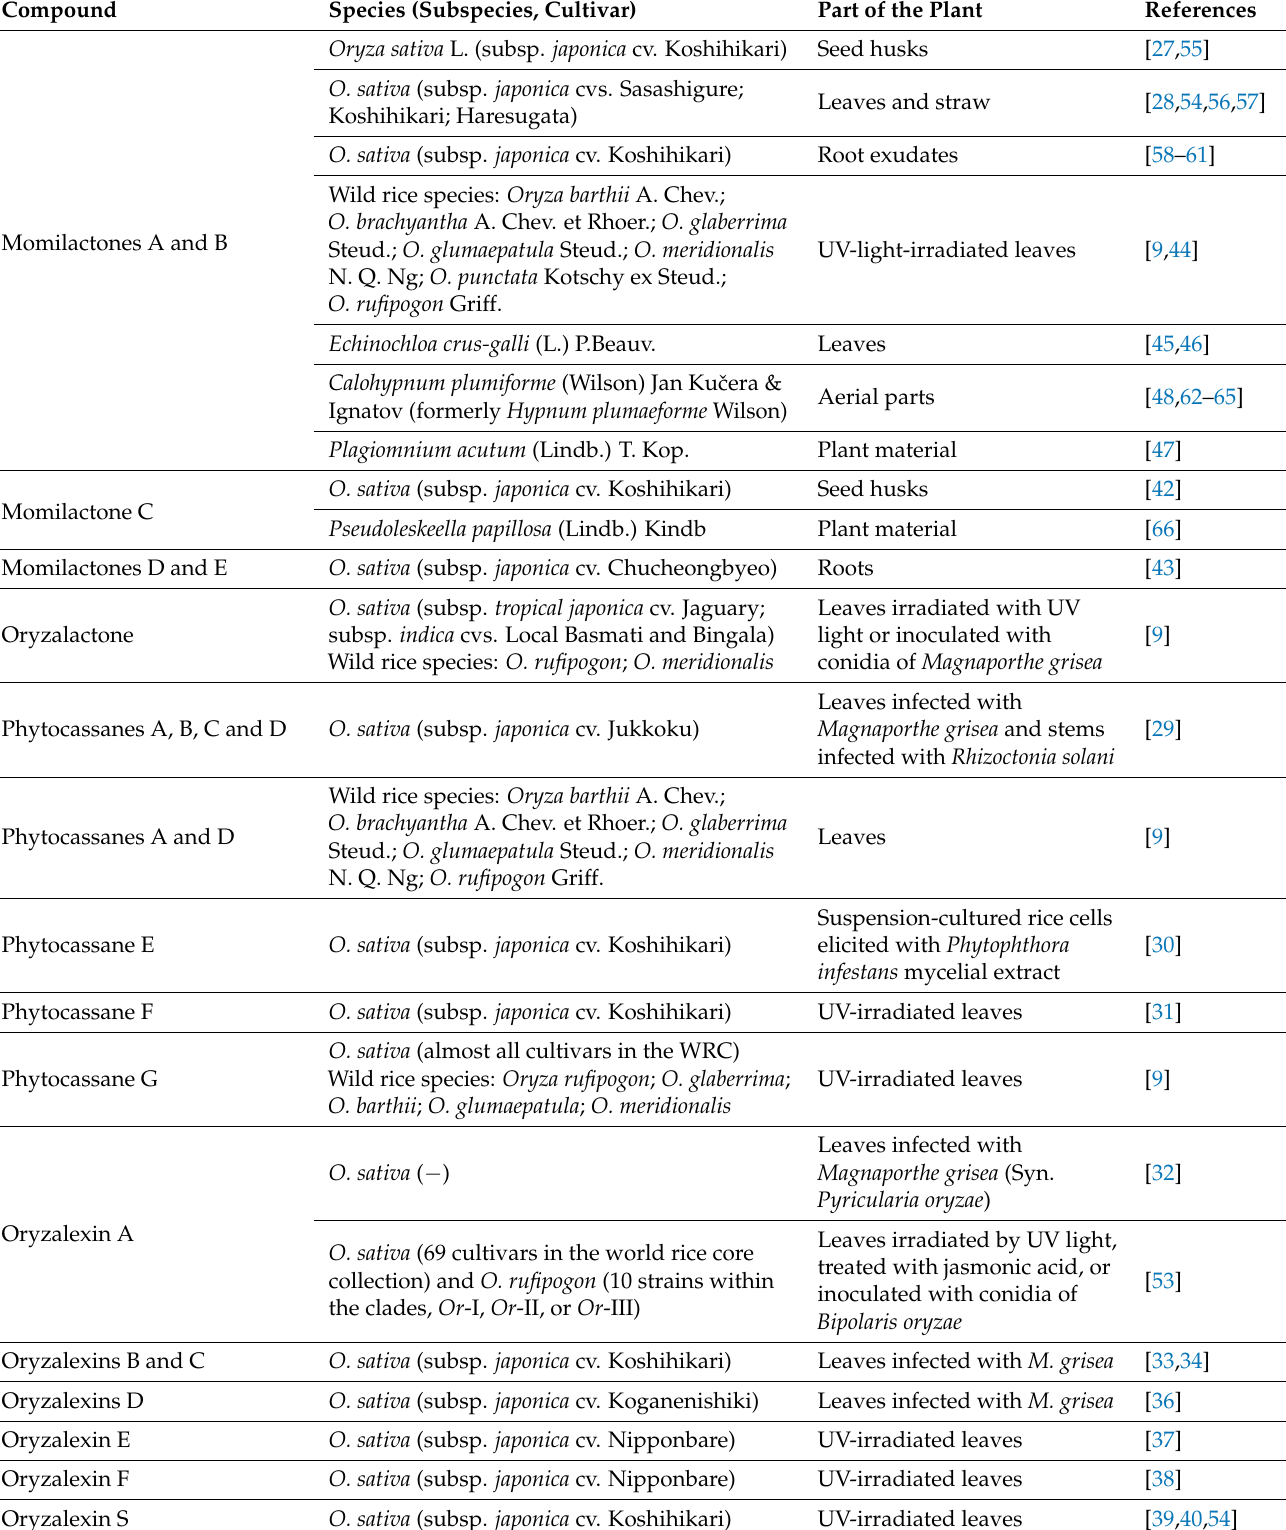
Table 1. Distribution of rice diterpenoid